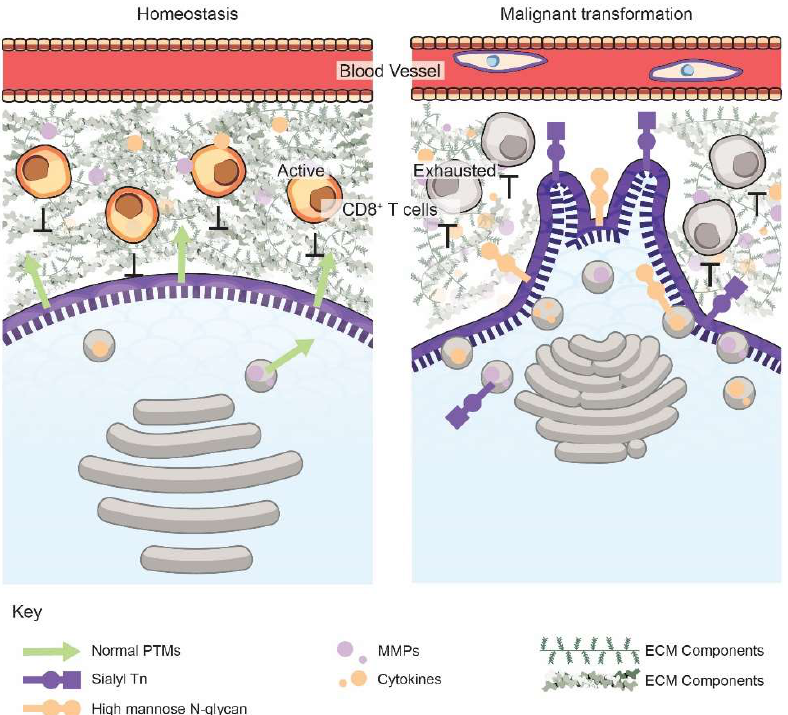
Figure 1. Golgi orientation, vesicular trafficking, and secretion are dysregulated upon malignant transformation. The functions, morphology, and orientation of the Golgi within a cancer cell (right) are modified, resulting in targeted exocytosis of invasive components, such as MMPs (purple dots) or cytokines (orange dots). This secretion mediates degradation of the ECM comprising of collagens, proteoglycans, etc., as well as suppression of the immune landscape. Malignant cells also have altered glycobiology and glycocalyces, such as specific surface PTMs, including sialyl Tn (purple square and circle) and high mannose N-glycans (orange circles), which promote invasion and intravasation. The unique proteoglycans and PTMs on cancer cells can serve as diagnostic or prognostic biomarkers for early cancer detection or personalized therapeutics.